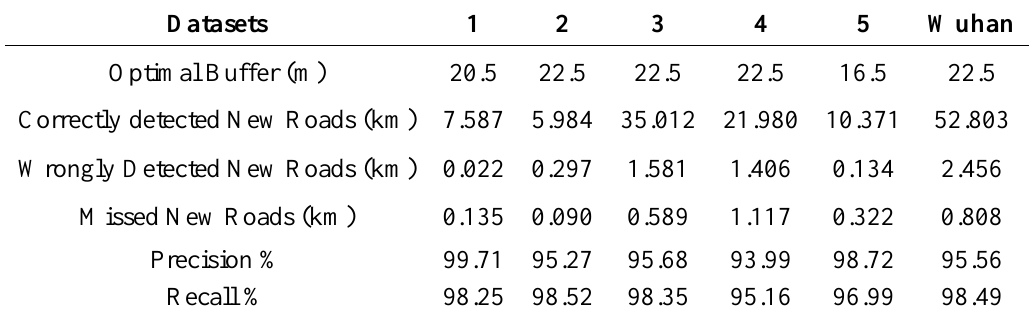
Table 3. Selected optimal buffer radii, detected new roads and evaluations for the five subsets and the city of Wuhan. Note: 100 roads of the Wuhan dataset were randomly selected for